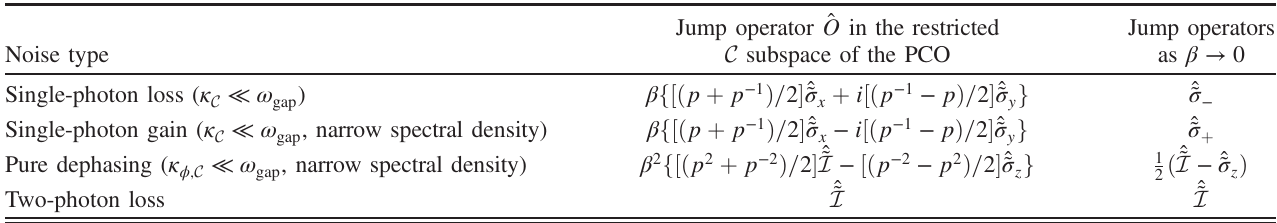
TABLE I. In general, interaction with the environment can lead to single-photon loss, single-photon gain, pure dephasing, and two- photon loss. When the coupling to the environment is smaller than the energy gap ω , then excitations out of the cat subspace C are gap negligible, and the dynamics of the PCO can be restricted in C . In this effective two-level system, the effect of the noise source can be ˆ ˆ ˆ ˆ ˆ ˆ ˆ ˆ O (cid:2) ˆ ρ ¼ O ˆ ρ O † − ð O † O ˆ ρ þ ˆ ρ O † O Þ = 2 , where O is the jump operator which depends on the type of described with the Lindbladian D ½ noise. The Lindbladian is derived using the Born approximation, along with the assumption that the spectral density of the noise is flat around the PCO frequency ω . The noise spectral density at the gap frequency is assumed to be small. For more discussion on these PCO approximations, see Appendixes B – D. The jump operators corresponding to single-photon loss, single-photon gain, pure dephasing, p ffiffiffiffiffiffiffiffiffiffiffiffiffiffiffiffiffiffi ffiffiffiffiffiffiffiffiffiffiffiffiffiffiffiffiffiffi p 1 þ e − 2 β 2 1 − e − 2 β 2 = , and, for large β , ð p þ p − 1 Þ = 2 ∼ 1 while and two-photon loss in a PCO are listed here. Here, p ¼ ð p − 1 − p Þ = 2 ∼ e − 2 β 2 . Therefore, we find that, as the size of the cat state increases, the only effect of the environment is to cause bit flips in the cat subspace. As β approaches 0, the cat states j C (cid:3) β i approach the Fock states j n ¼ 0 ; 1 i , respectively. In this limit, the effect of noise reduces to the jump operators in a conventional two-level system as listed in the third column here. ˆ O in the restricted Jump operator Jump operators C subspace of the PCO Noise type as β → 0 Single-photon loss ( κ C ≪ ω ) gap Single-photon gain ( κ C ≪ ω , narrow spectral gap